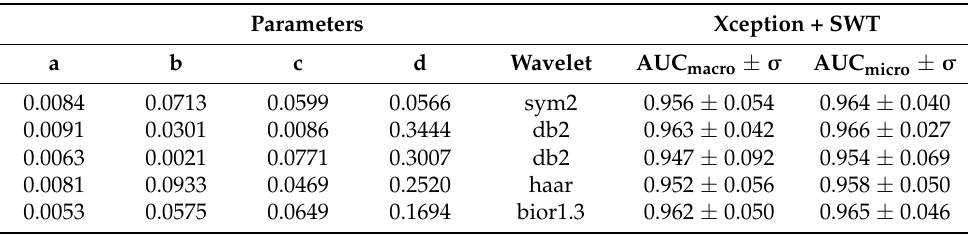
Table 6. Constants of coefficient mapping function obtained using Bayesian optimization along with corresponding 5-fold cross-validation performance. Parameters Xception + SWT